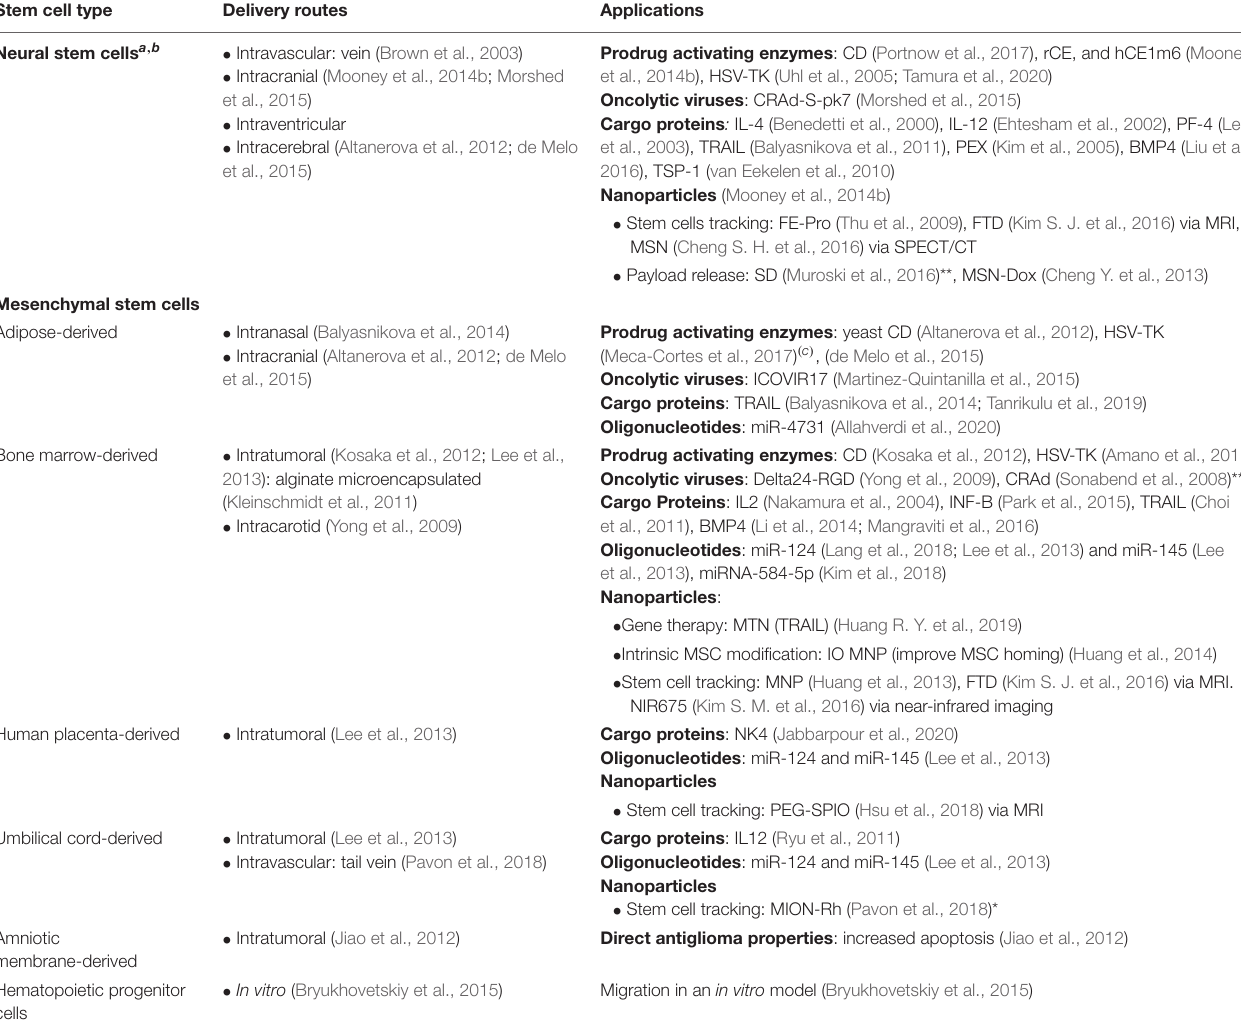
TABLE 2 | Stem cell therapy in